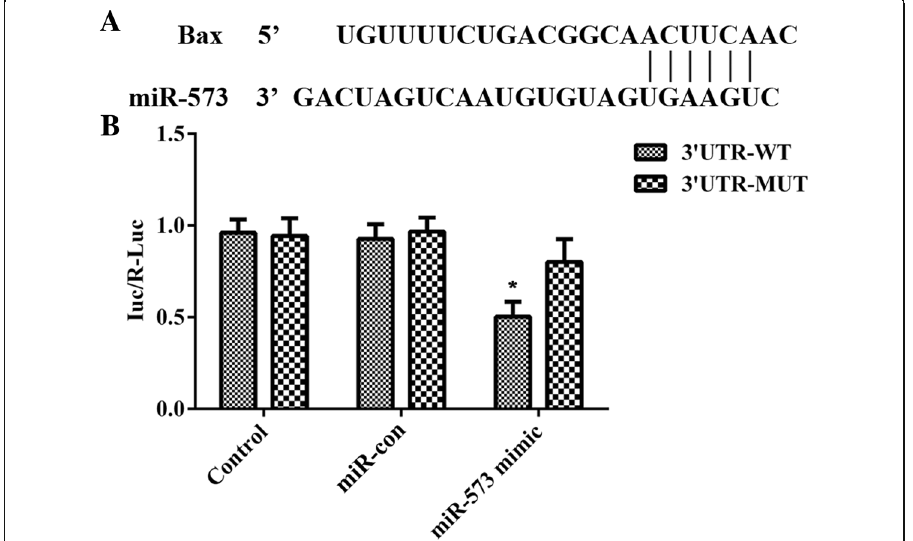
Fig. 5 Bax is a target gene of miR-573. a Predicted miR-573 target sequence in the 3 ′ -UTR of Bax. b Luciferase activity of control, miR-con and miR-573 group in degenerative NP cells. * P <0.05 versus 3 ′